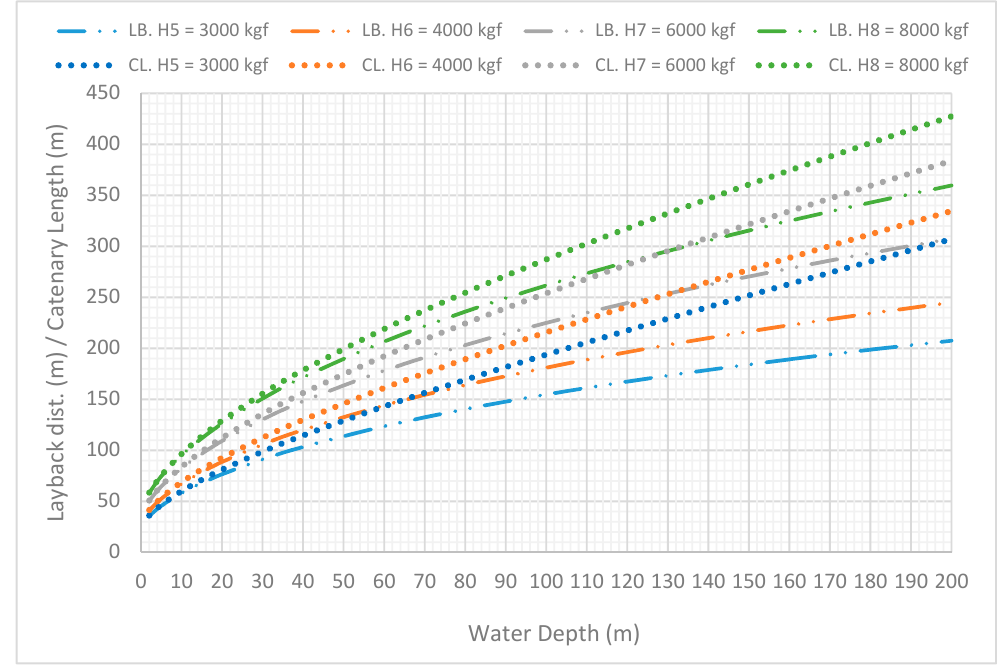
Figure 5. Layback distance (LB) and catenary length (CL) using various bottom tension values (3000 kgf–8000 kgf) and water depths (2 m–200 m).